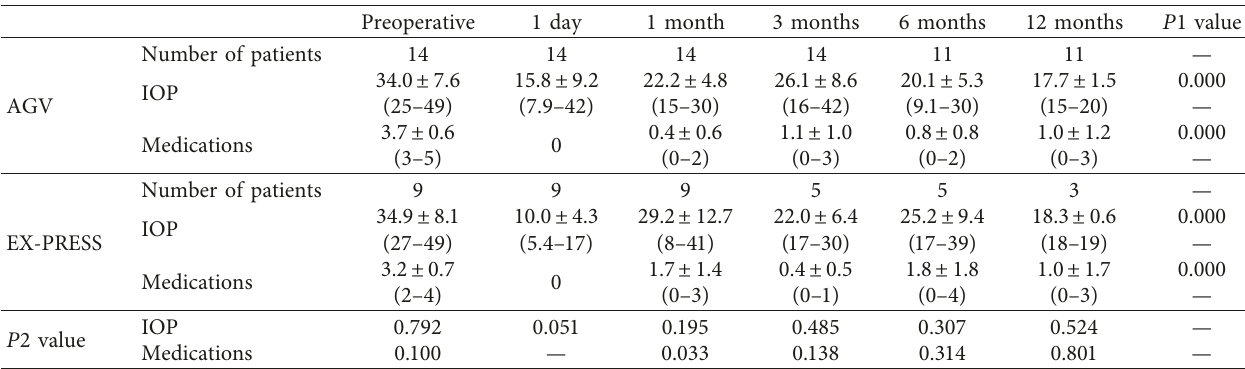
Figure 2: (a) The line graph of intraocular pressure before surgery and one day, one month, three months, six months, and twelve months after surgery. (b) The line graph of the number of medications used before surgery and one day, one month, three months, six months, and twelve months after Table 2: Preoperative and follow-up outcomes.